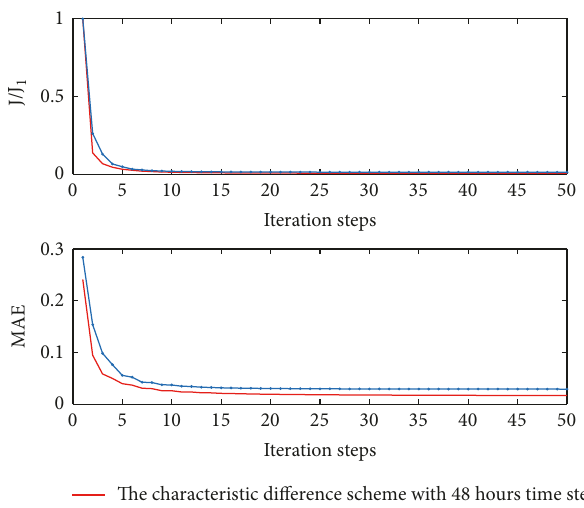
Figure 4: The descending curves of the relative magnitude of the cost function 𝐽/𝐽 1 and the mean absolute error (MAE) of observation points using CFD and CDS with different time steps.